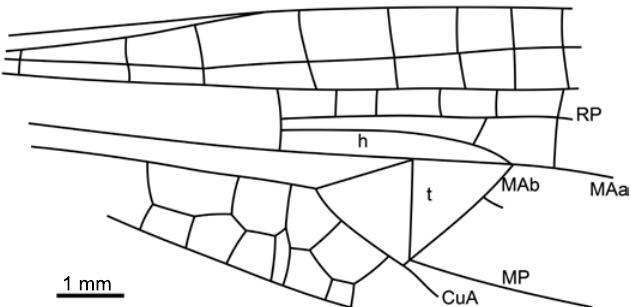
Fig. 2. Reconstruction of forewing base of anisopteran odonatan Macro- gomphus menatensis sp. nov., holotype MNT Nel 4173; from Paleocene, Menat,